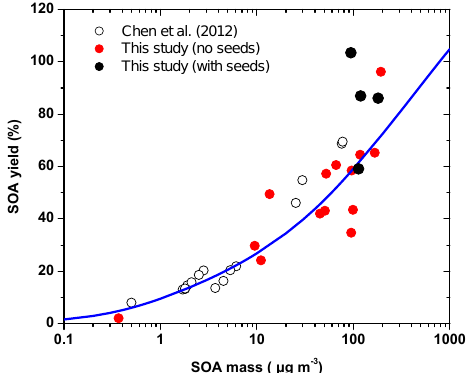
Figure 1. The measured aerosol mass concentration in the chamber as a function of time and the wall-loss-corrected SOA mass concen- tration (for w = 1) for Experiment 1. Also shown is the time when the temperature inside the chamber was increased.